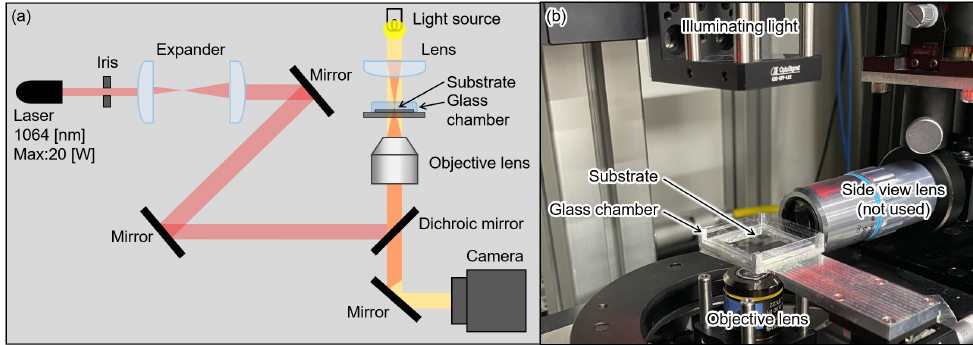
Figure 6. Experimental system. ( a ) System schematic. ( b ) Picture of experimental